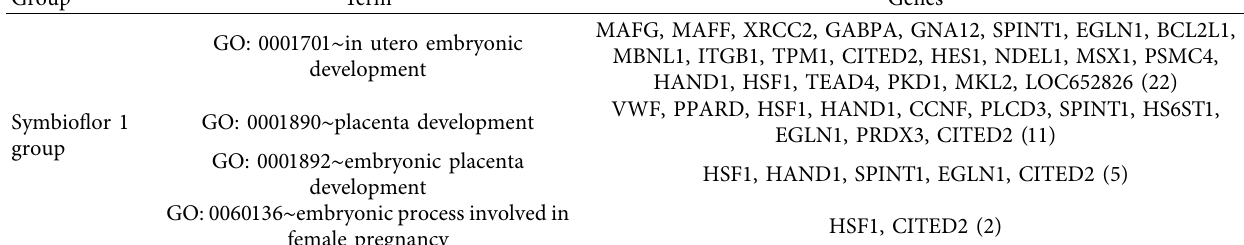
Table 3: DEGs classified into placenta and embryonic development of the GO biological process category.